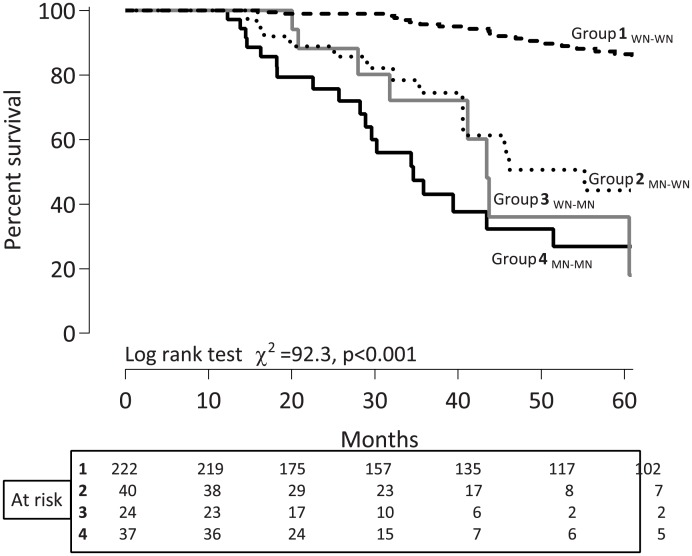
Kaplan—Meier plot for all-cause mortality of the four groups of patients according to the nutritional status change assessed by SGA.Abbreviations: Group 1 WN-WN, patients who remained well-nourished during follow up; Group 2 MN-WN, patients who were improved with nutritional status during follow up; Group 3 WN-MN, patients who developed PEWSGA during the follow-up; Group 4 MN-MN, patients who remained with PEWSGA at baseline and at follow-up.